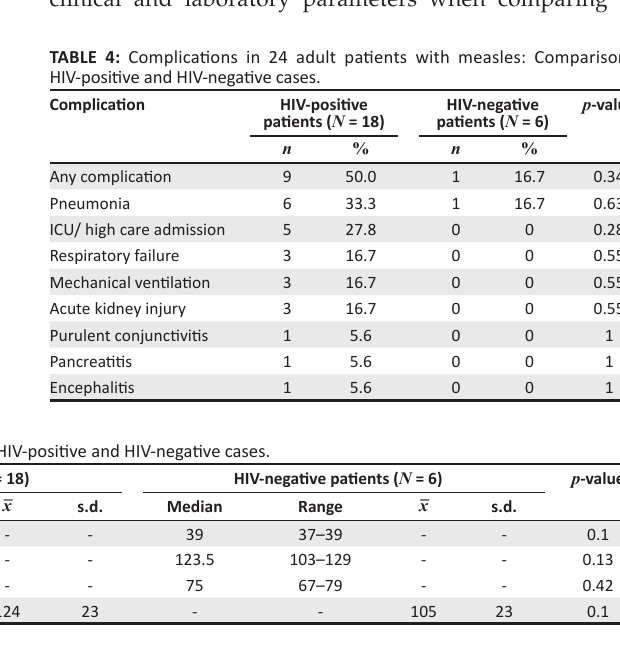
TABLE 2B: Examination findings in 24 adult patients with measles: Comparison of HIV-positive and HIV-negative cases. Clinical features